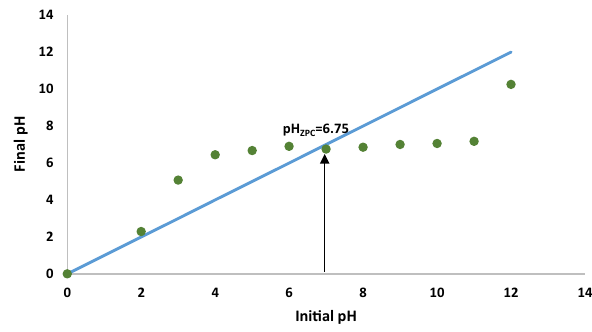
Fig. 4 Effect of pH on zeta potential of the S.